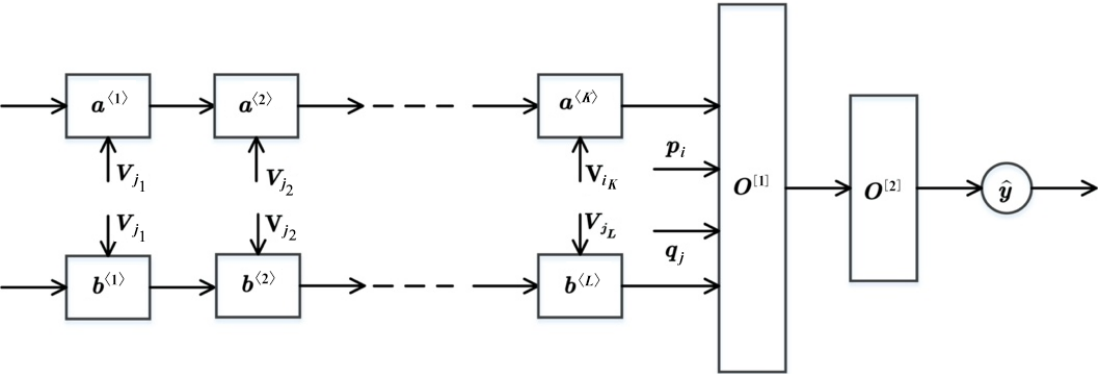
Fig. 1 Architecture of the